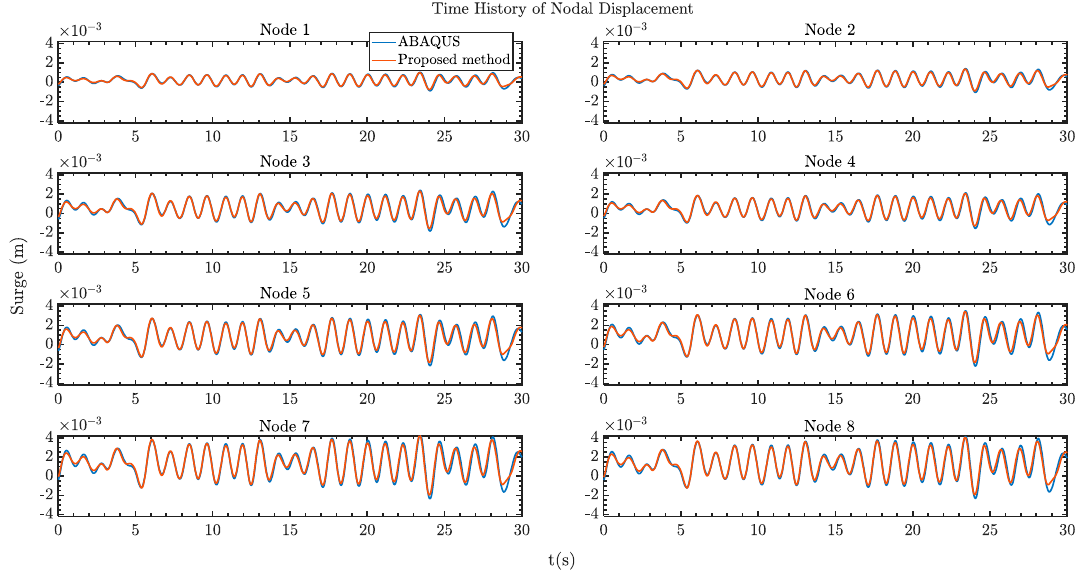
Figure 12. Comparison of the time history of nodal displacement in surge under irregular wave